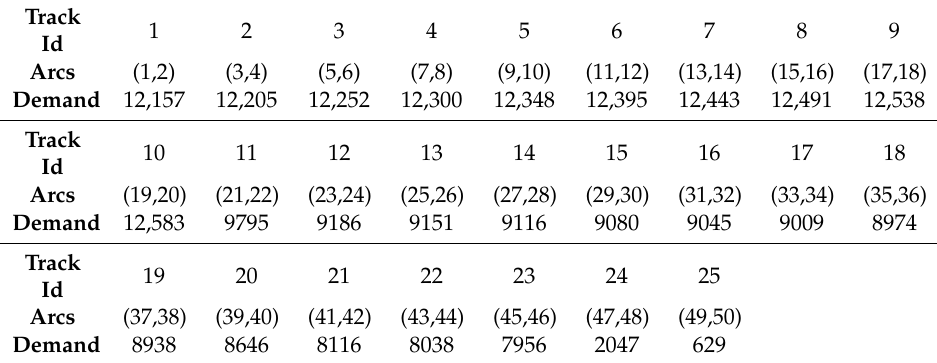
Table 6. The list of track Id and corresponding sibling arcs and demand